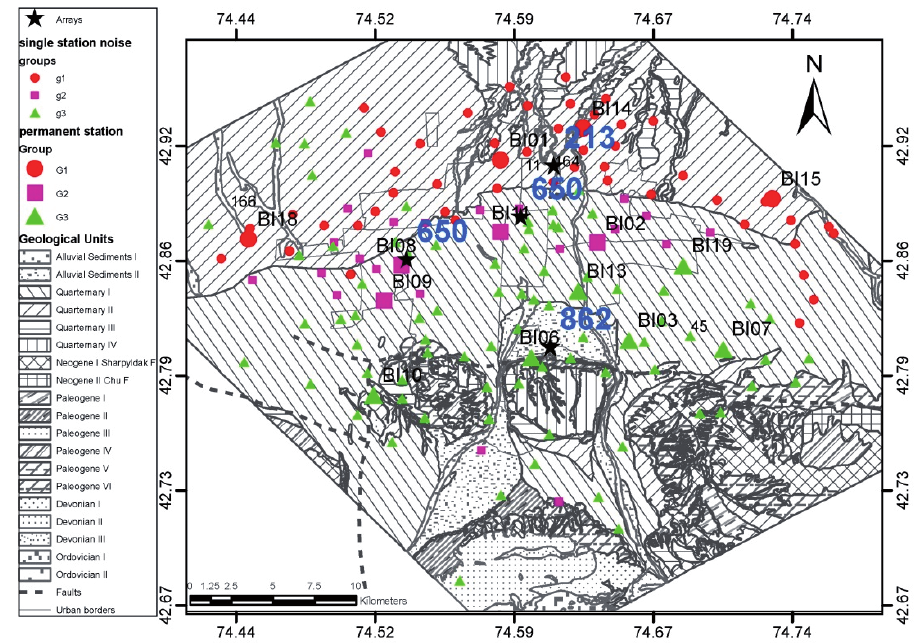
Figure 5. Array locations (black stars) with Vs30 values (blue color). The different colors of the stations (single station noise measurements and permanent stations) represent different clusters in terms of the similarity of site effects from SSR (modified from Ullah et al.